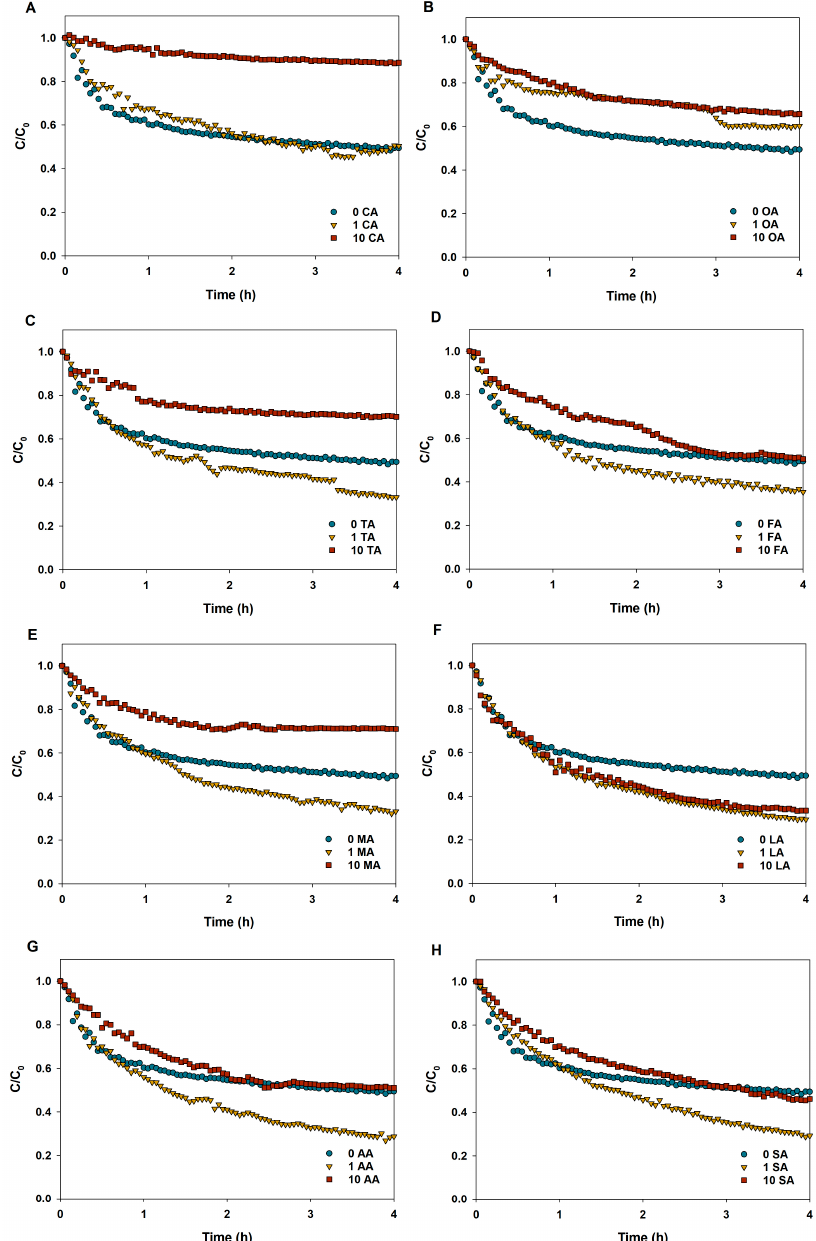
Figure 5. Sedimentation rate of CuO NPs (100 mg/L) in aqueous solutions with different LMWOAs. ( A ) CA: Citric acid; ( B ) OA: Oxalic acid; ( C ) TA: Tartaric acid; ( D ) FA: Formic acid; ( E ) MA: Malic acid; ( F ) LA: Lactic acid; ( G ) AA: Acetic acid; ( H ) SA: Succinic acid.